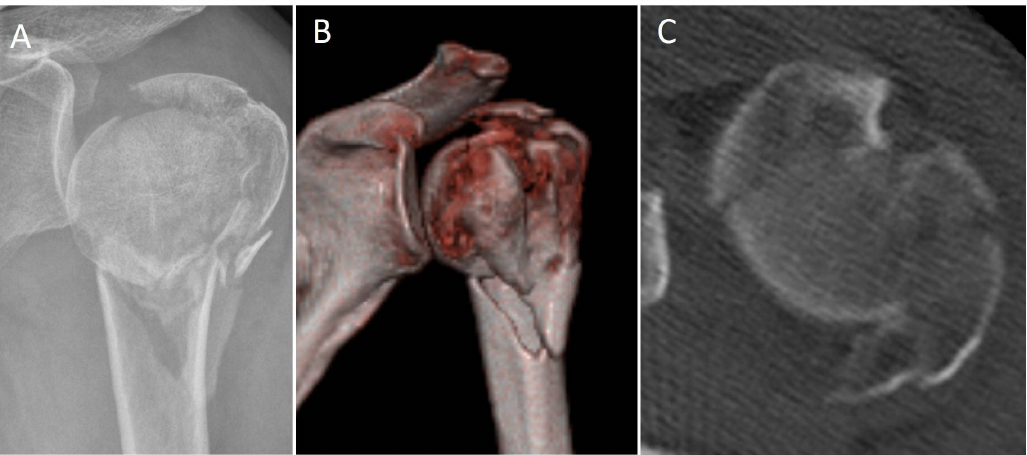
Figure 1. ( A , B ): X-ray and 3D CT-scan of a 59 year old female patient with a Resch 4GL type PHF. ( C ): Axial CT-scan shows the head-split of the articular surface type III accord to Scheibel et al. [9].